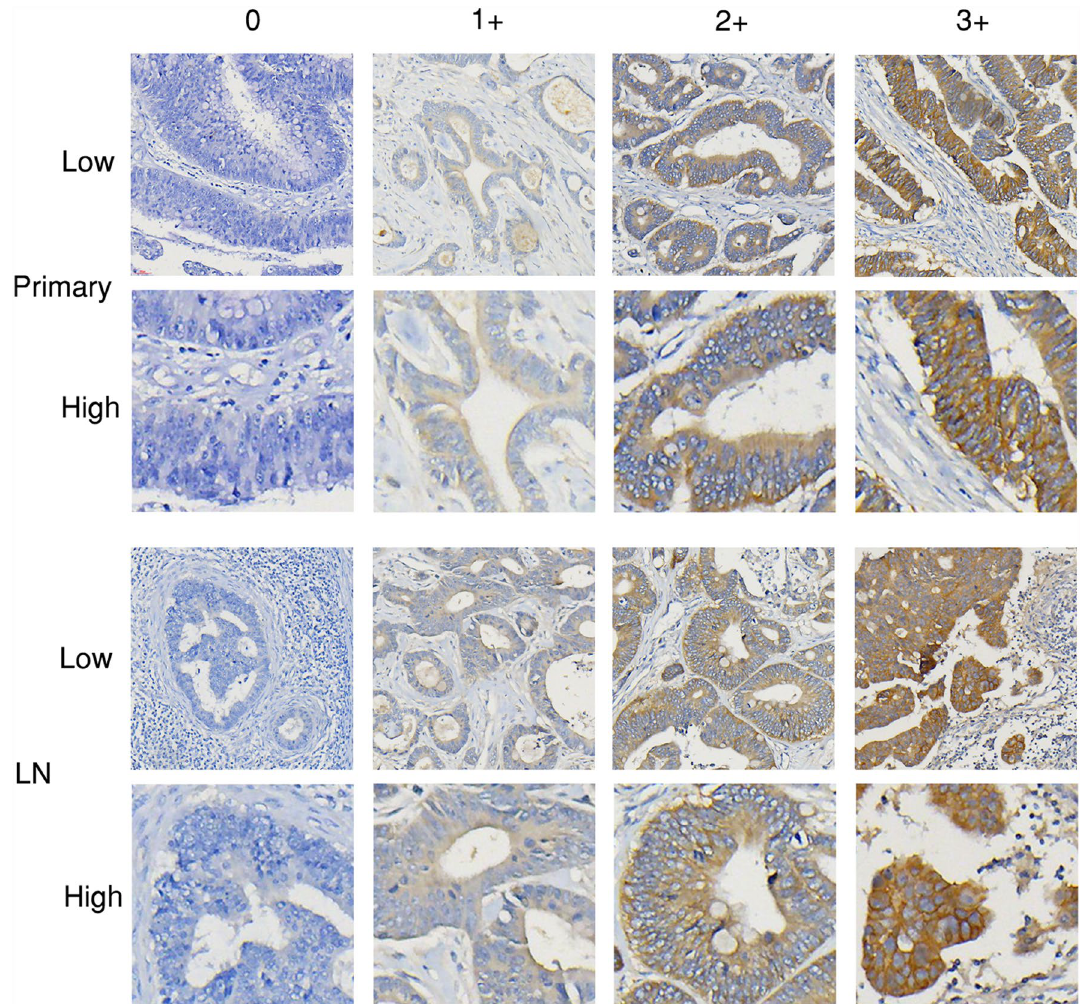
Figure 2. Representative images (HER2 immunohistochemistry staining). Representative images of immunohistochemistry staining scores (0, 1+, 2+, and 3+) for HER2 in primary tumor (Primary) and lymph node metastasis (LN) of CRC. Low: low magnificent power field (× 40); High: high magnificent power field (×